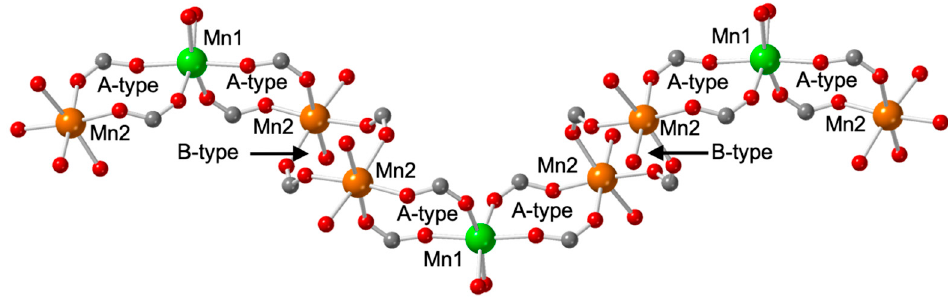
Figure 2. View of the -Mn-(OC(R)O) 2 -Mn- chains formed by double syn-anti carboxylate bridges in 1 showing the A-type and B-type Mn dimers.